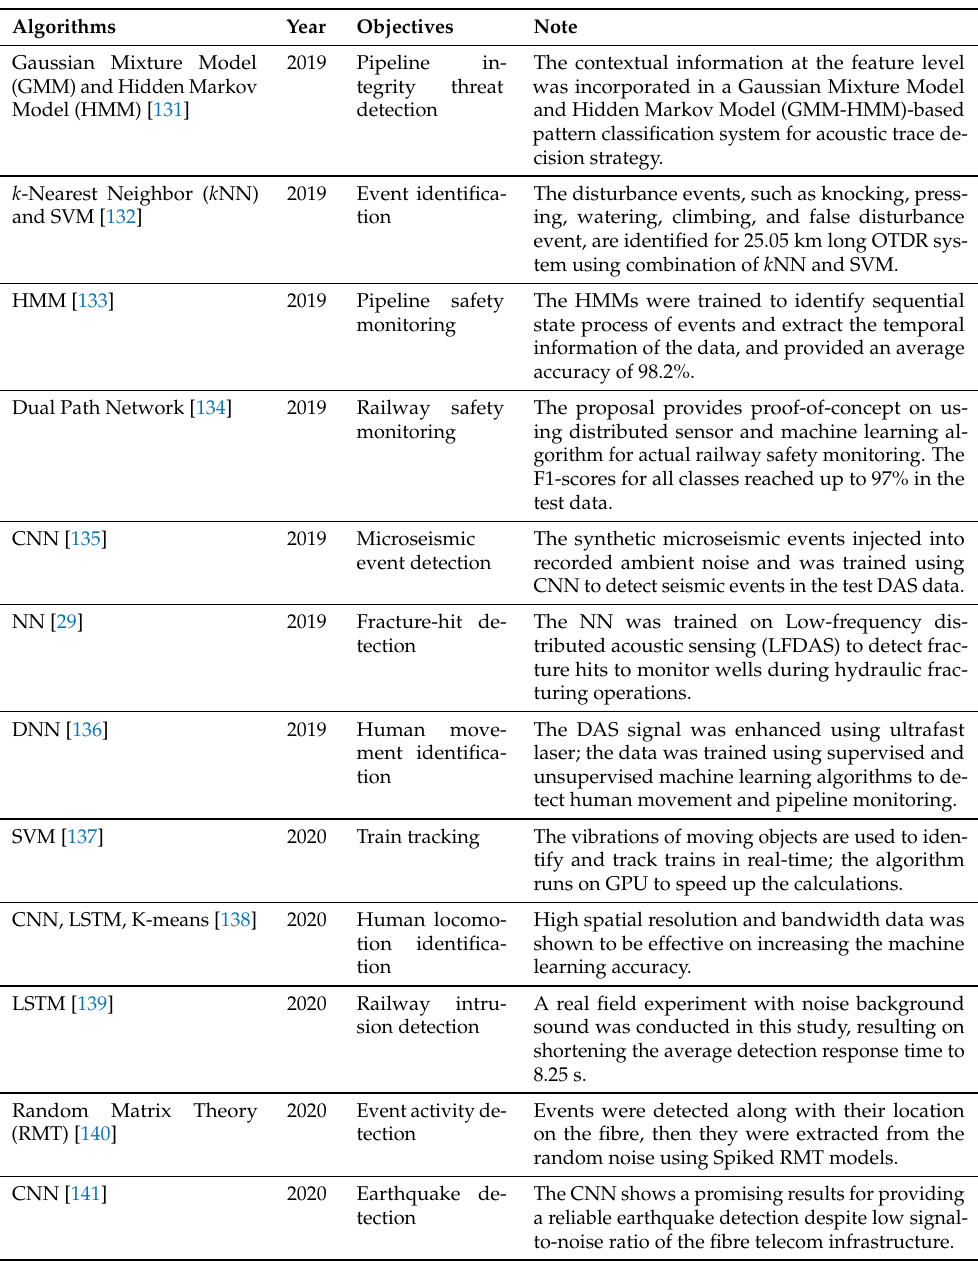
Table 3. Recent work concerning machine learning algorithms for modelling distributed fibre optic sensor data for non-multiphase fluid flow